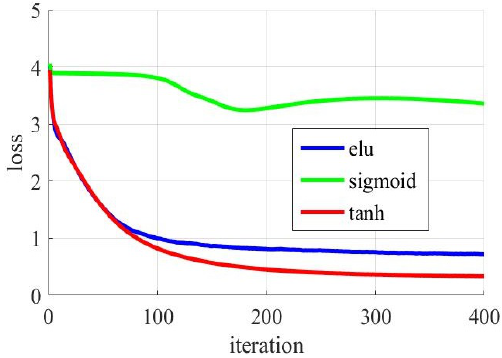
Figure 12. Localization precision with different activation